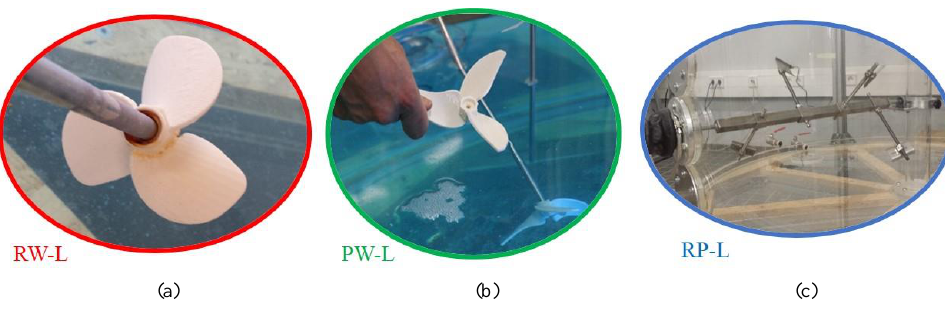
Fig. 1. Typology of the agitators: (a) propeller with three rounded blades and Ø = 7.5 cm, called RW-L; (b) propeller with three pointed blades and Ø = 12.5 cm, called PW-L; (c) paddle with four rectangular plates of 4.5·7 cm dimension, called RP-L.